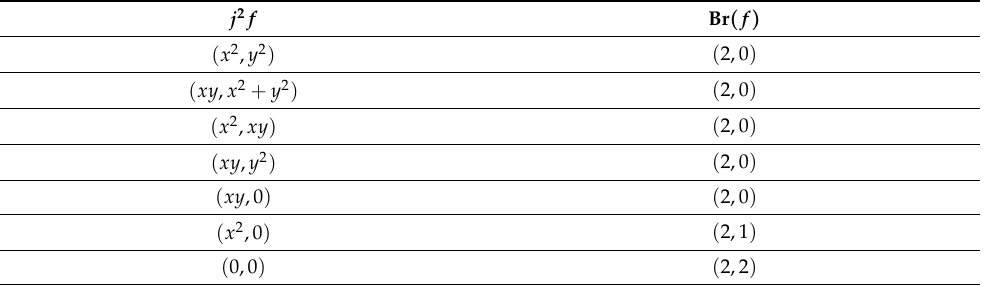
Table 3. Normal form of second jet of simple map